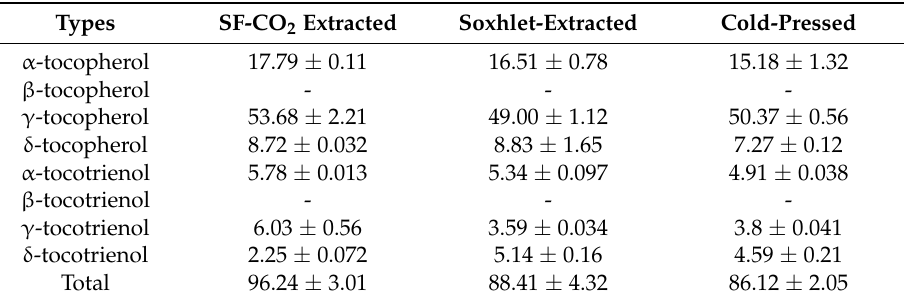
Table 4. Composition of tocopherols and tocotrienols in EDS oils (mg/100 g). Types SF-CO 2 Extracted